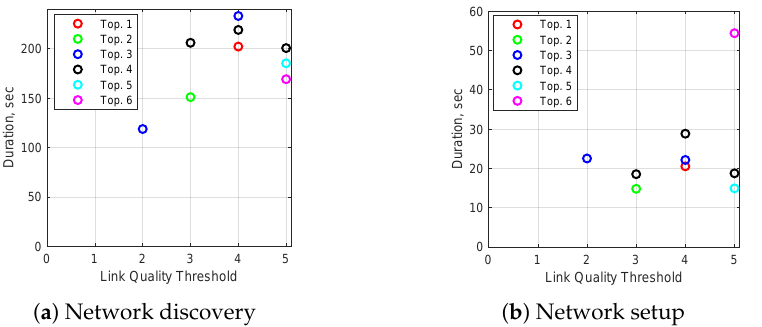
Figure 15. The duration of the ( a ) network discovery and ( b ) network setup stages in the Heslington East lake trials (Top. n —topology n from Figure